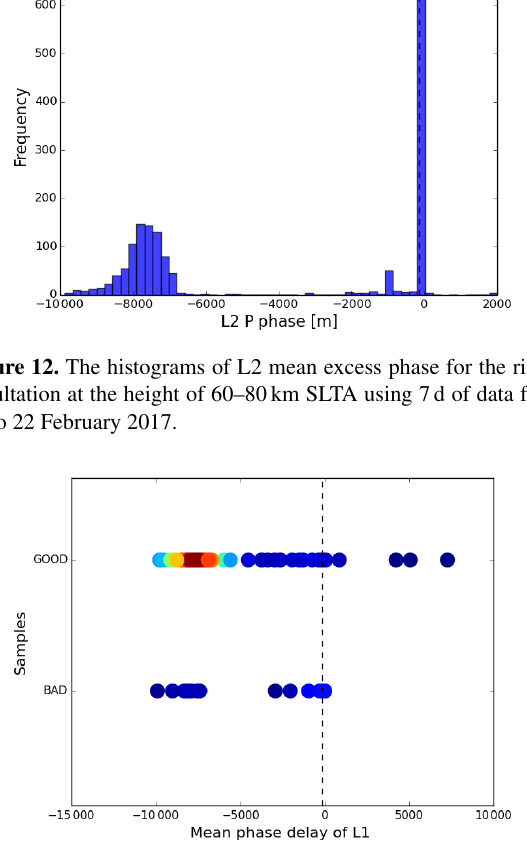
Figure 11. The histograms of L1 mean excess phase for the rising occultation at the height of 60–80km SLTA using 7d of data from 16 to 22 February 2017.